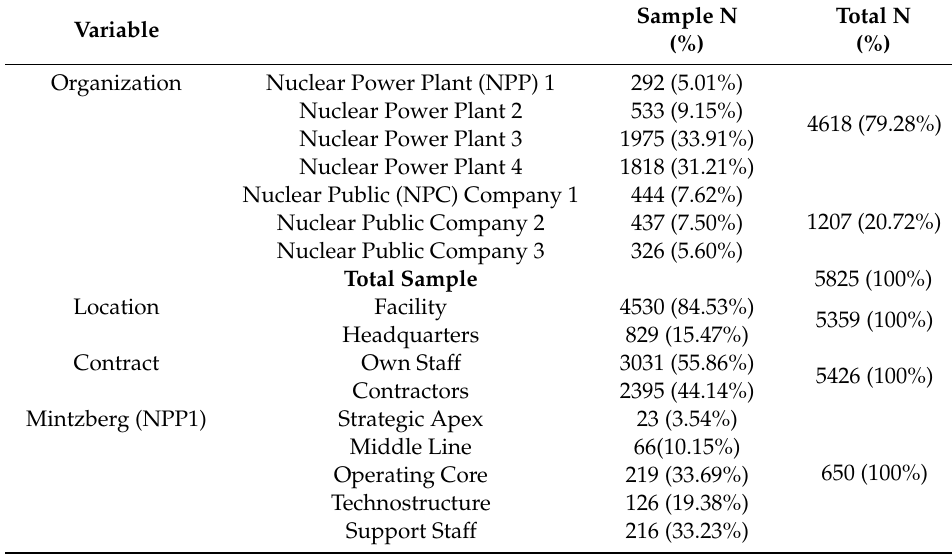
Table 1. Study sample and